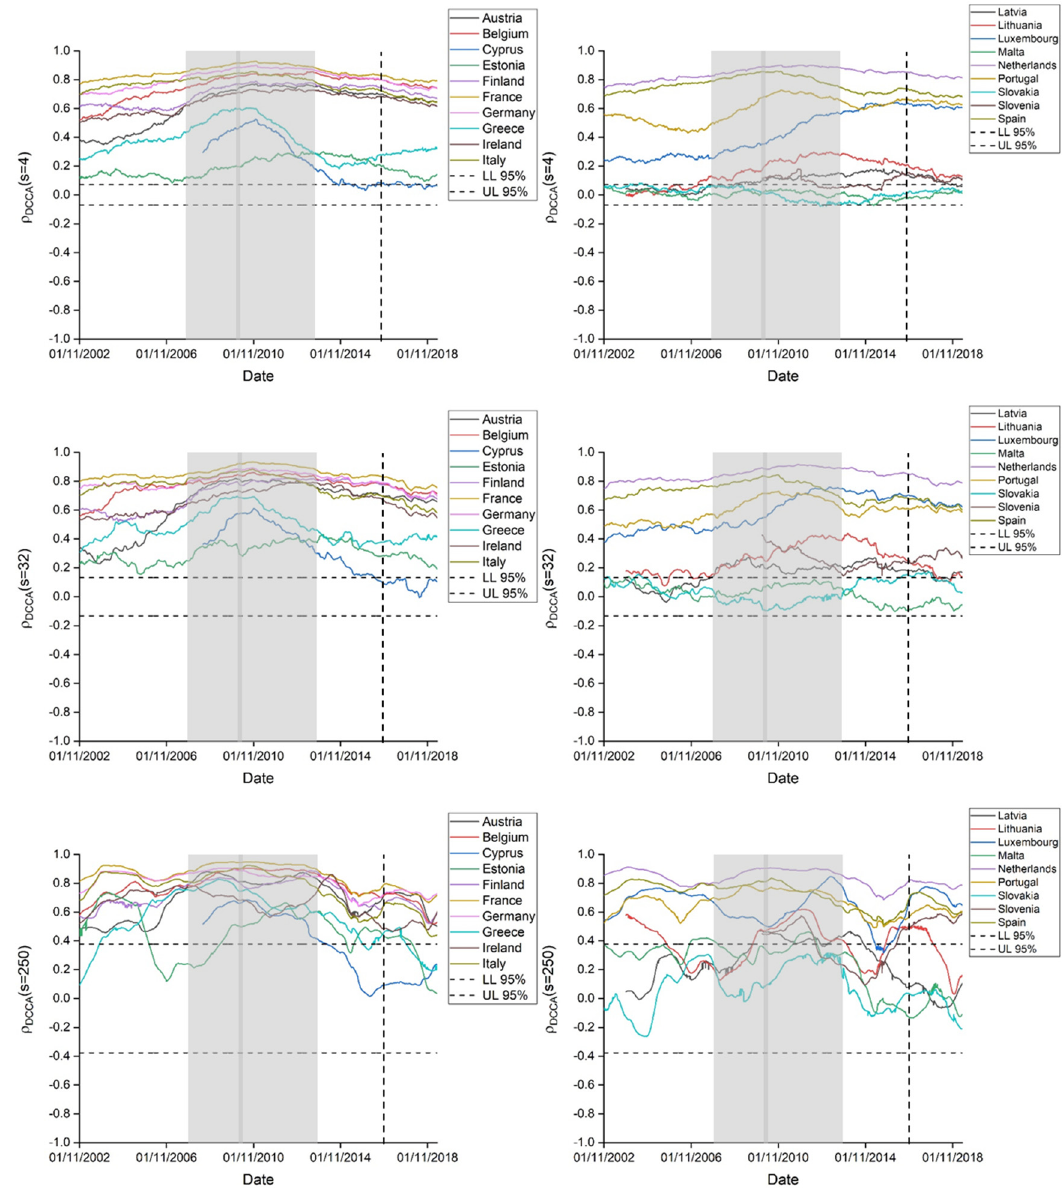
Figure 2. Evolution of ρ DCCA between Eurozone stock markets and the UK (time scales of 4, 32, and 250 days and window size w = 1000). LL and UL are, respectively, the lower and upper limits of the confidence interval. Shaded areas represent the global financial crisis and the Eurozone debt crisis. The vertical dashed line refers to the moment of the Brexit referendum.